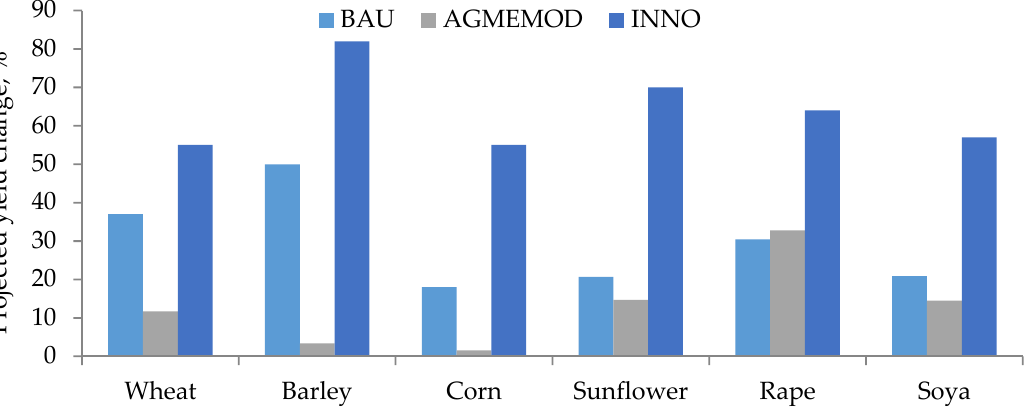
Figure 3. Projection of changes in yields for selected crops in Ukraine by 2030 (compared to average yields in 2008–2014). Source: Agricultural Member State Modeling (AGMEMOD) modeling results [39] and own calculations (business-as-usual (BAU), innovative (INNO)) based on the Global Biosphere Management Model (GLOBIOM).